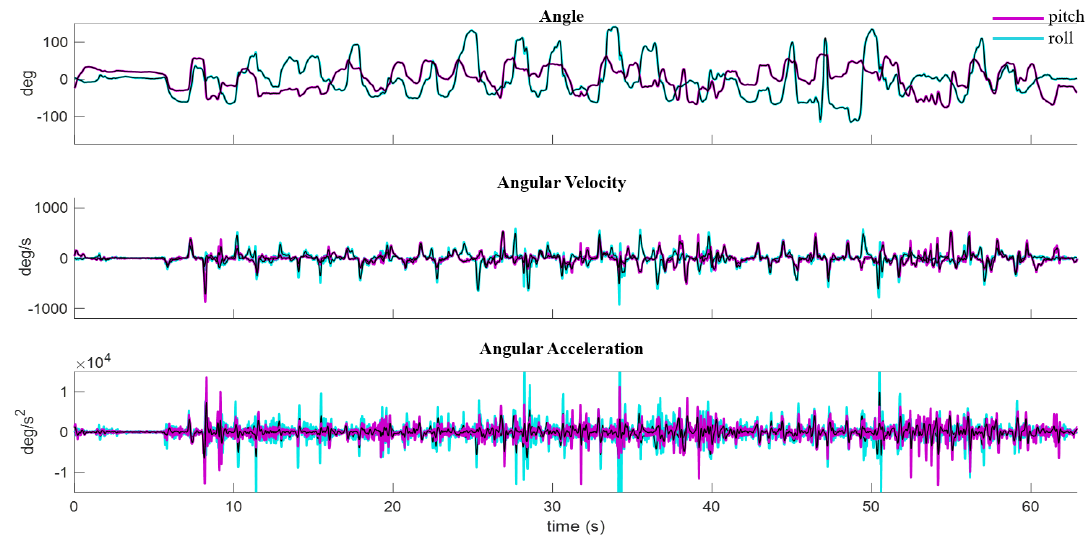
Figure 5. XSens IMU filtered (black) and unfiltered pitch (magenta) and roll (blue) angle, angular velocity, and angular acceleration signals versus time for a single trial.